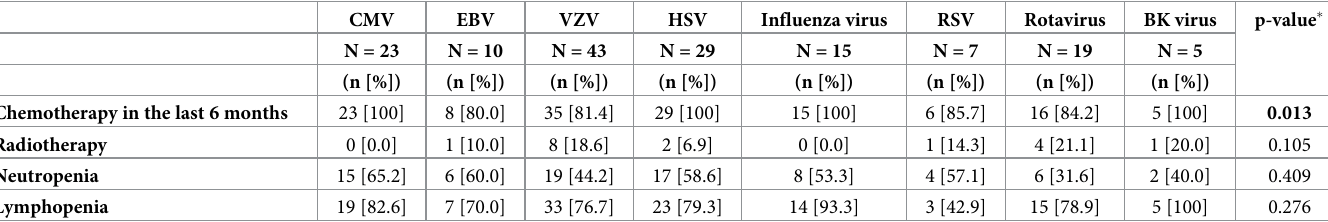
Table 3. Risk factors and laboratory findings of different viral infections in children and adolescents with